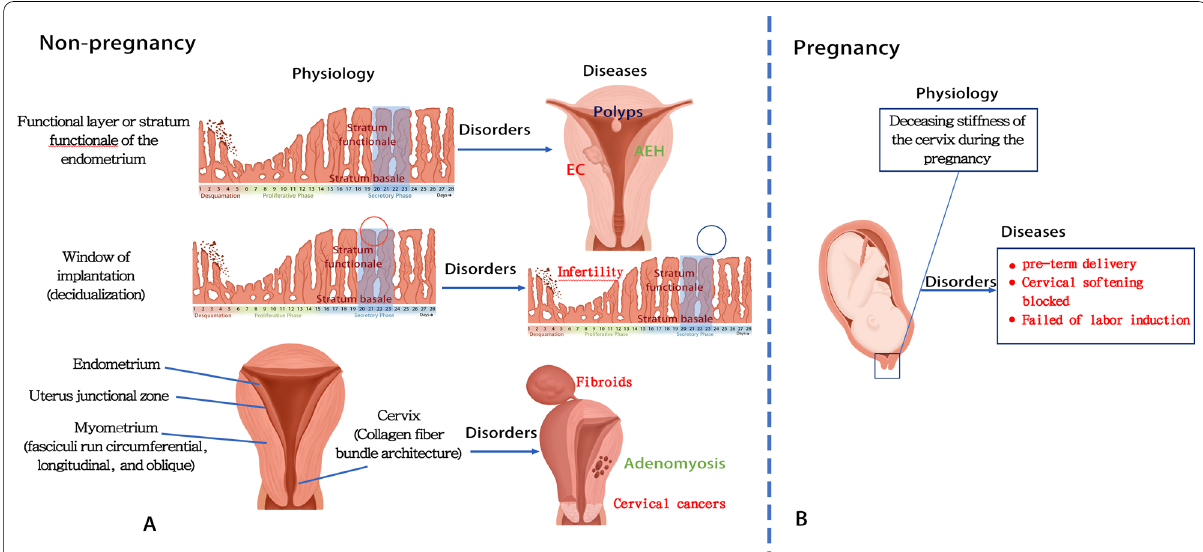
Fig. 1 Potential involvement of stiffness in uterus disorders. A is for non‑gestation period while B is for gestational period. The stiffness of uterus fibroids, EC, cervical cancers, infertility, and disorders in the cervix during pregnancy increases than normal tissues (Red font), as well as endometrium polyps decrease (blue font). AEH and adenomyosis are still uncertain (green font). AEH atypical endometrial hyperplasia, EC endometrium